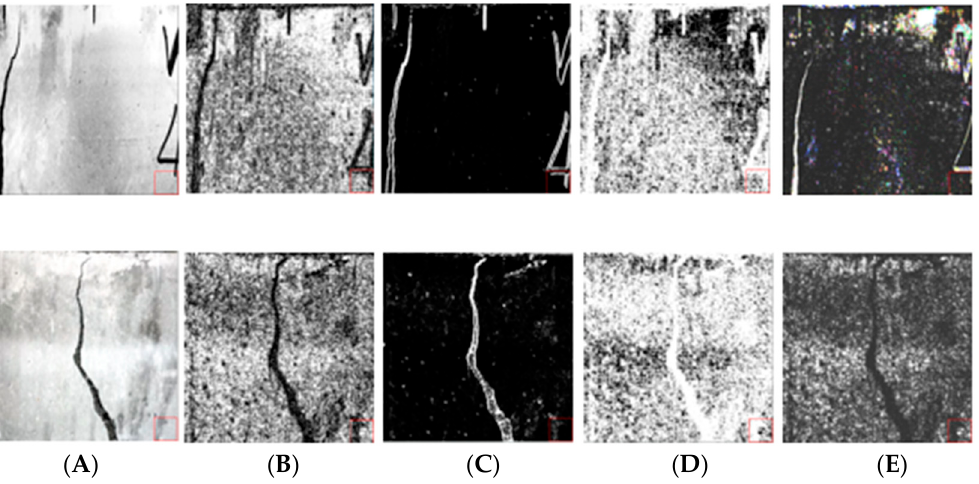
Figure 7. Texture feature images. ( A ) Original images; ( B ) homogeneity images; ( C ) contrast images; ( D ) entropy images; ( E ) ASN images.